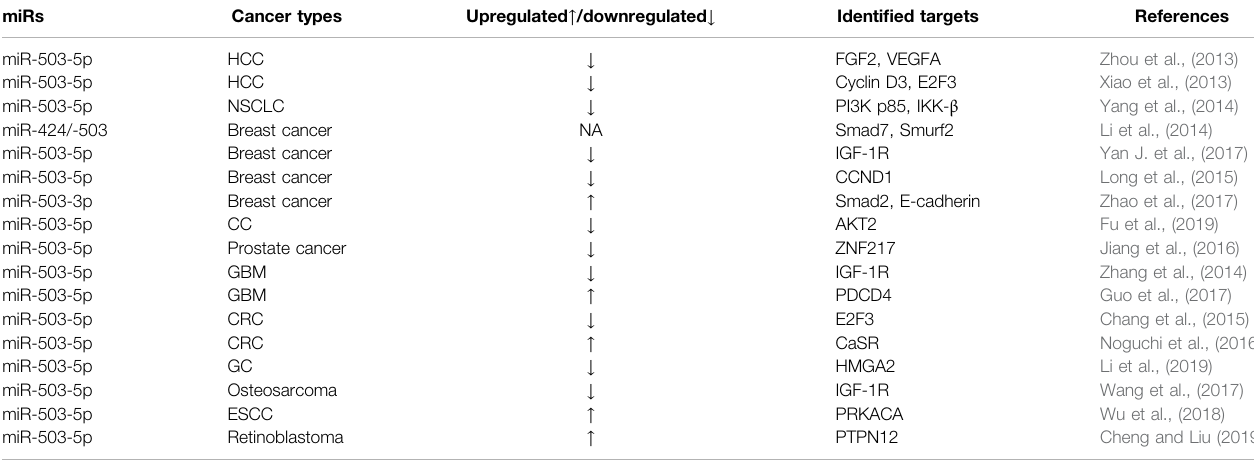
TABLE 2 | The expression level and targets of miR-503 in cancer.